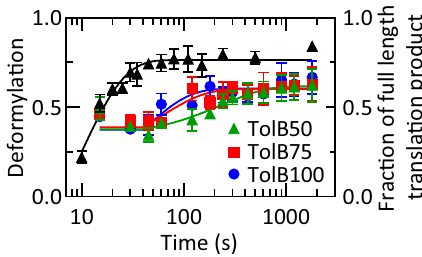
Figure 7. Co-translational deformylation of RNCs. Translation of TolB mRNA constructs of increasing length (50, 75, and 100 codons) was started with initiation complex (50 nM) by adding the components of the translation system and PDF (2 μM). Deformylation (colored symbols) is plotted on the left Y-axis, and translation of TolB50 mRNA (black triangles) on the right Y-axis. Co-translational deformylation time courses were fitted to delay-exponential equations (“Materials and methods”), and the rates of the multiple turnover phase were 0.004 s −1 (TolB50), 0.017 s −1 (TolB75), and 0.024 s −1 (TolB100). One-way ANOVA indicated higher rates for TolB75 and TolB100 compared to TolB50 (p = 0.018 and 0.0001, respectively), but no significant difference between ToB75 and TolB100 (p = 0.20). Error bars represent the standard deviation of three independent